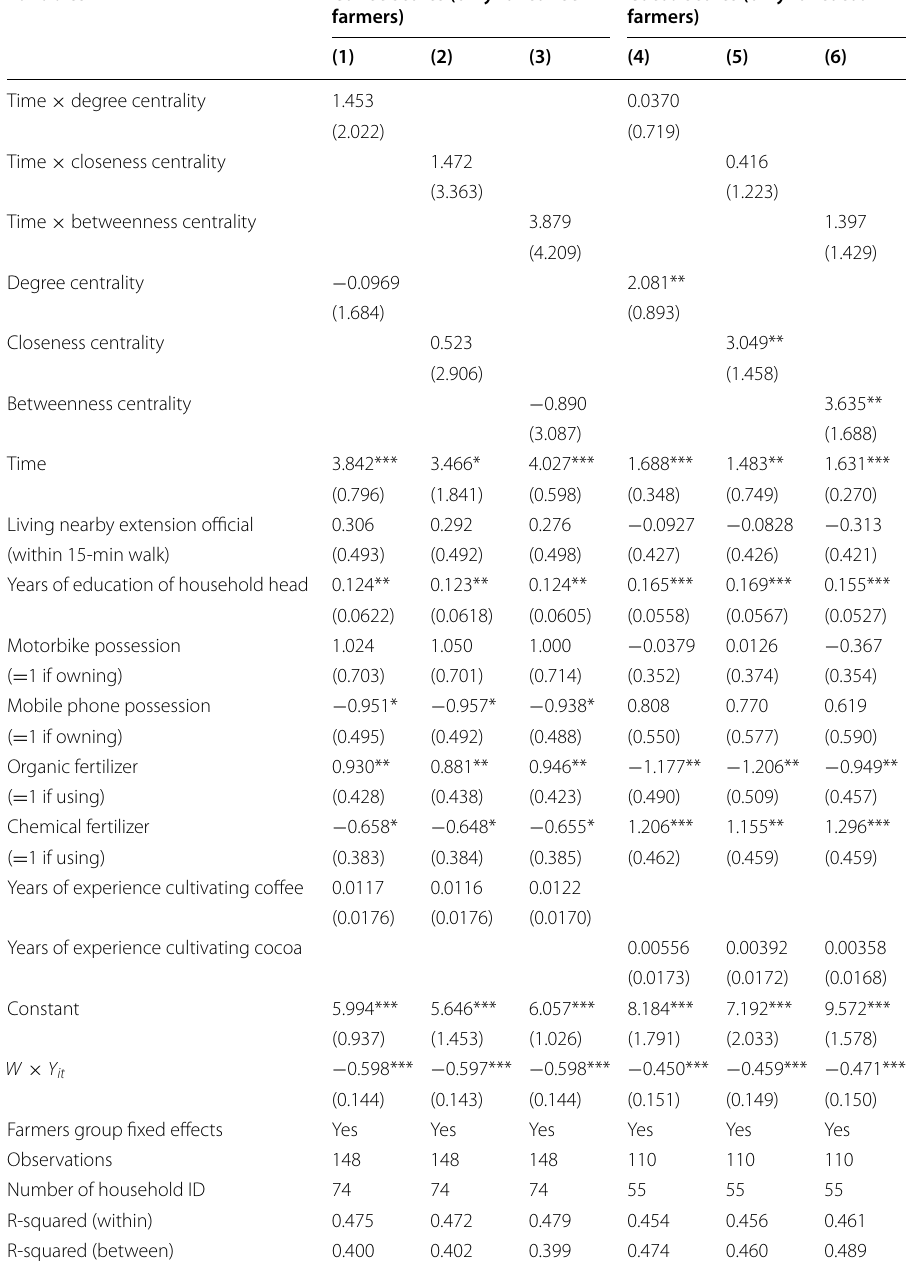
Table 9 Effects of network position in farmers group on knowledge